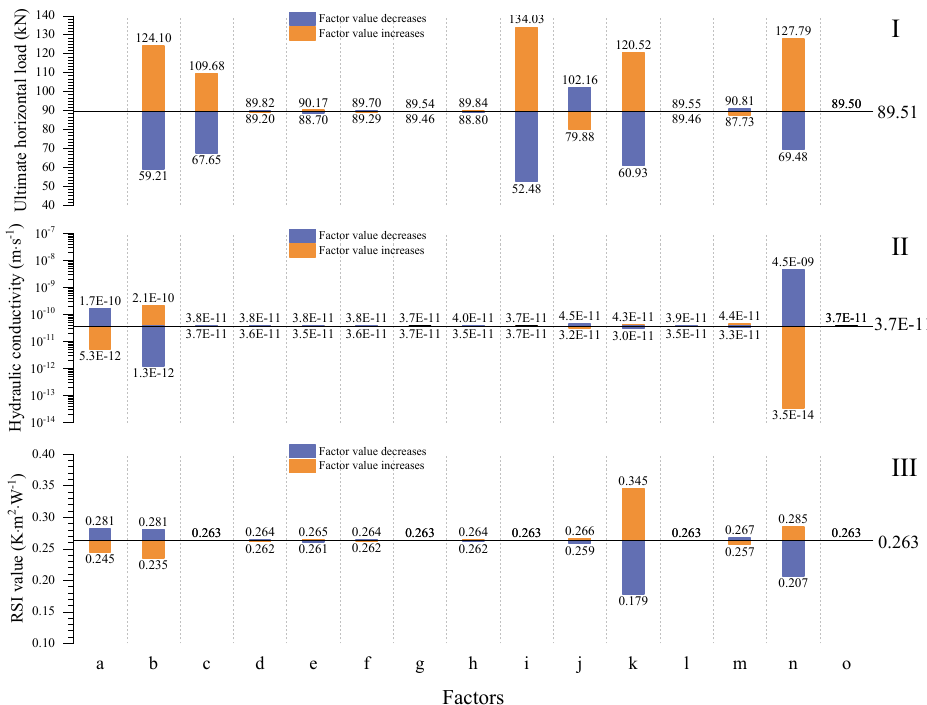
Figure 7. Variations of the ( I ) pushover strength, ( II ) average hydraulic conductivity, and ( III ) average RSI value of the walls built after five years according to (a) dry density, (b) fine content, (c) vertical load, (d) emissivity, (e) incoming shortwave radiation, (f) Munsell color value, (g) cloud cover, (h) outdoor wind speed at 10 m, (i) wall width, (j) wall height, (k) wall thickness, (l) average annual outdoor temperature, (m) average annual outdoor relative humidity, (n) ground surface suction, and (o) initial saturation of the wall.